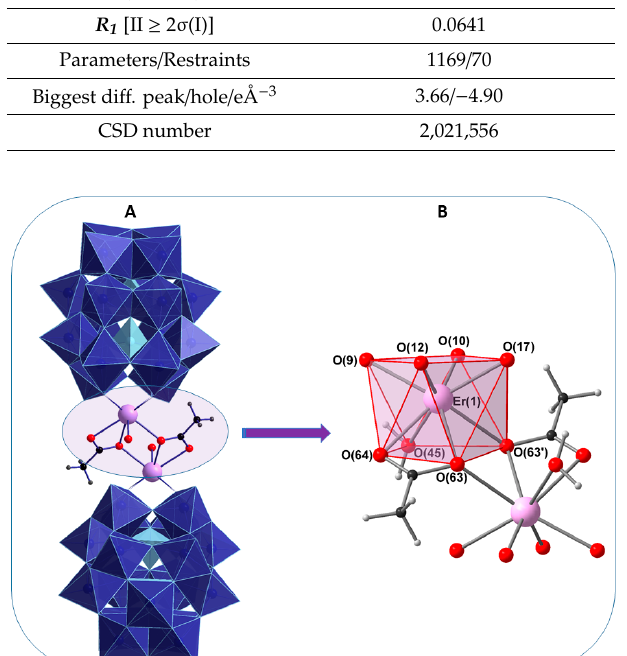
Figure 1. Combined polyhedral ( A ) / ball-and-stick ( B ) representation of 1 and the Er 2 core. Color code: WO 6 blue octahedra, PO 4 sky blue tetrahedra, Er lavender, O red, C black, H small gray